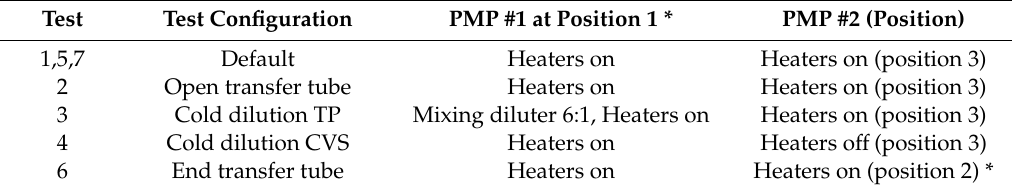
Table 1. Chronological order and experimental details of the various test